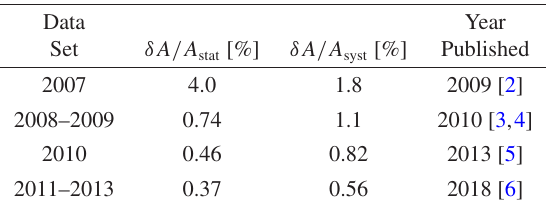
Table 3. Summary of all results from the UCNA experiment. Data